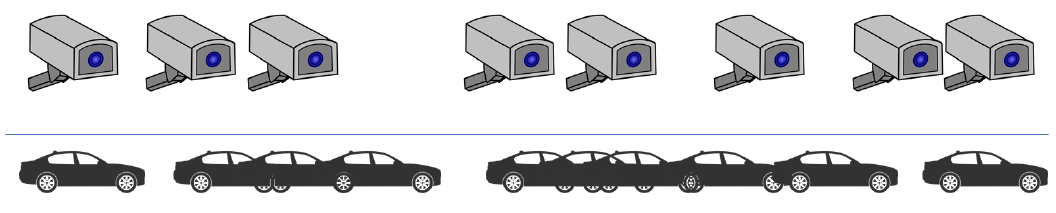
Figure 10. A scenario for the collaboration of CCTVs for tracking a car.